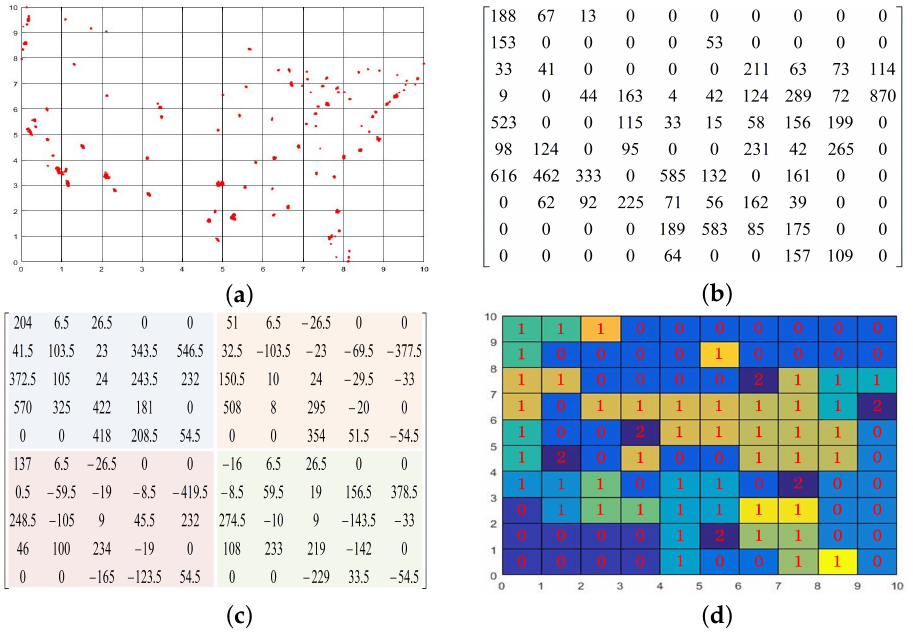
Figure 8. Grid partition and clustering process of Storage dataset. ( a ) grid partition; ( b ) density matrix; ( c ) coefficient matrix after DWT; ( d ) grid clustering result.